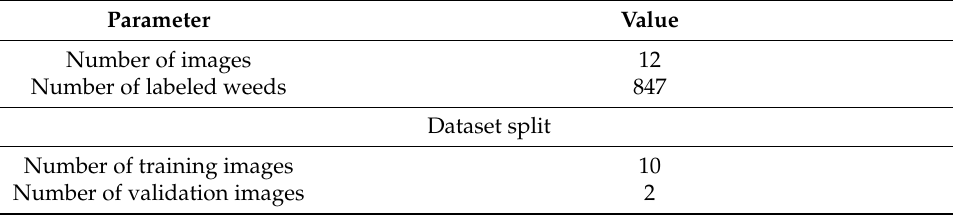
Figure 2. Examples of images in the weed dataset for the real-time application experiment. Table 4. Scope of the weed dataset for the real-time experiment.